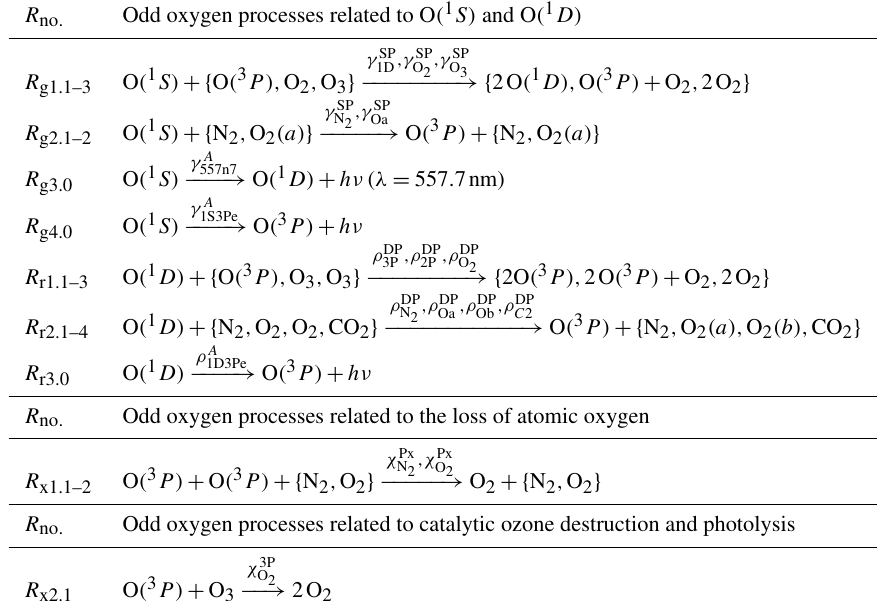
Table 7. The processes shown here comprise the MAC model together with the processes shown in Tables 5 and 6. R no